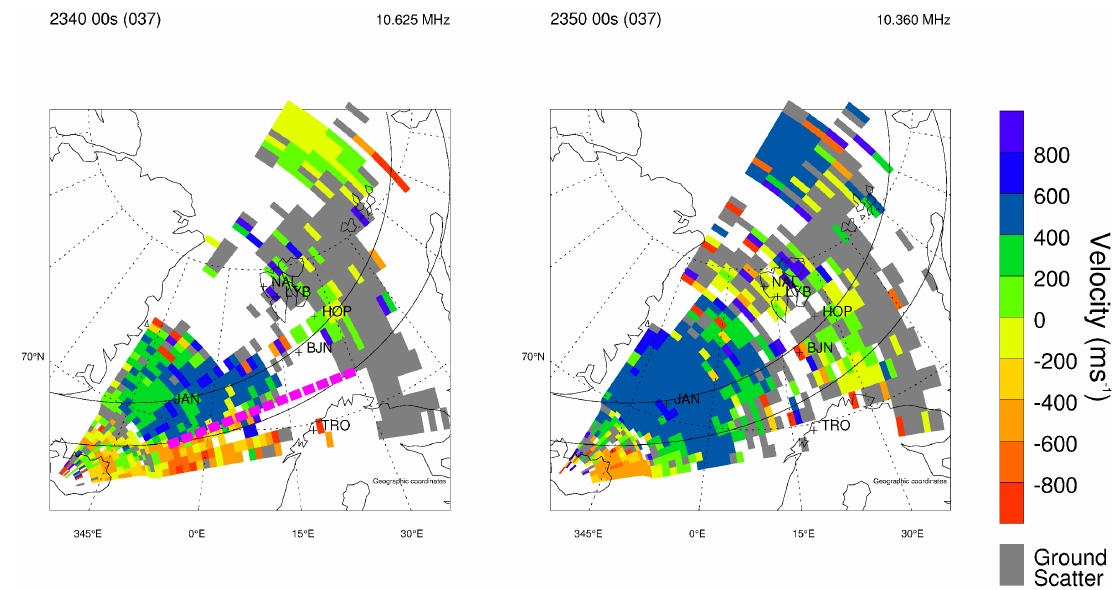
Fig. 5. Line-of-sight velocity (in m/s) from the CUTLASS Iceland East radar for 23:40 UT (left panel) and 23:50 UT (right panel). Positive values correspond to velocities towards the radar, negative ones are away from the radar. The pink dashed line in the left panel marks the location of the